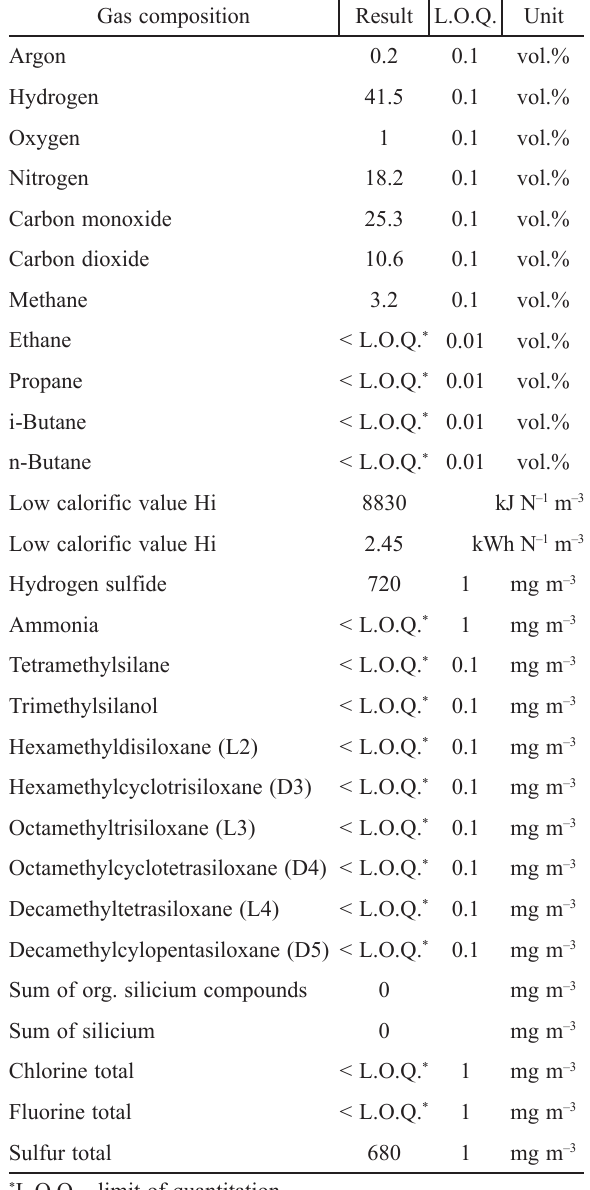
Table 3 – Proportions of raw materials and water in the brick mixture (wt.%) Raw materials